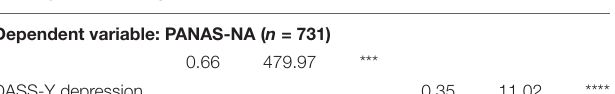
TABLE 7 | DASS-Y scales predicting scores on measures of positive affect, life satisfaction, physiological hyperarousal, excessive worry, and negative affect in the primary and high school samples